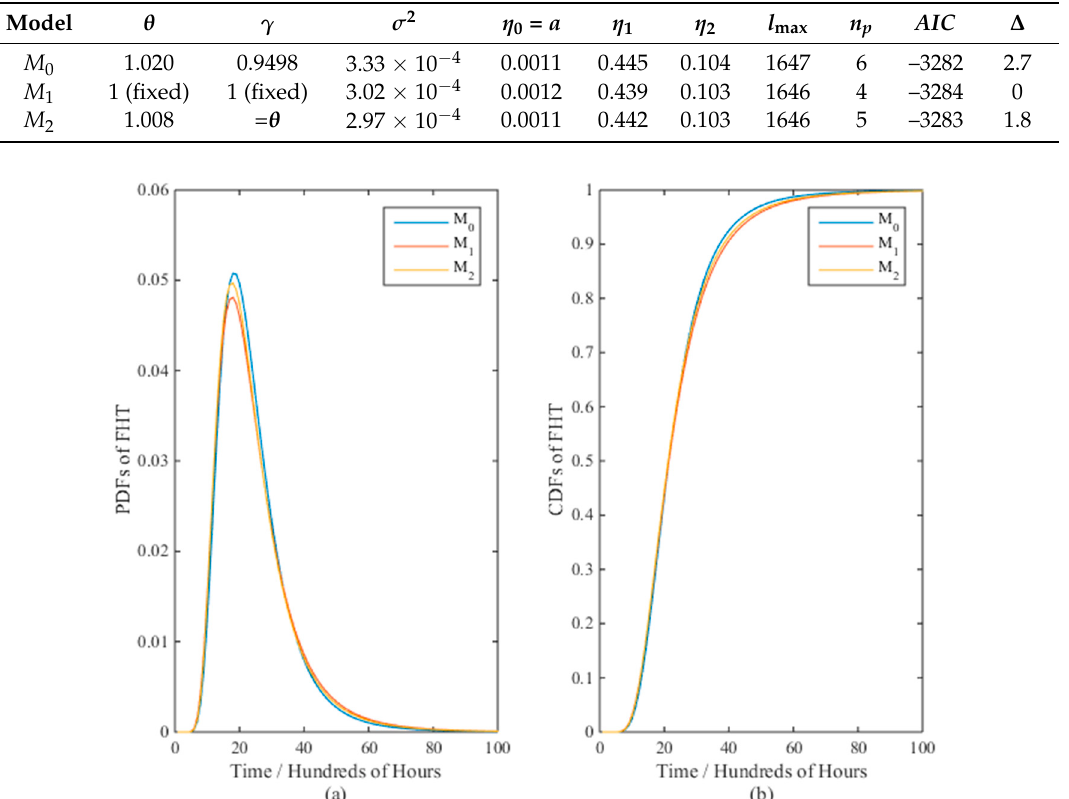
Figure 10. The ( a ) PDFs and ( b ) CDFs of the FPT for three candidate models in the resistor case.